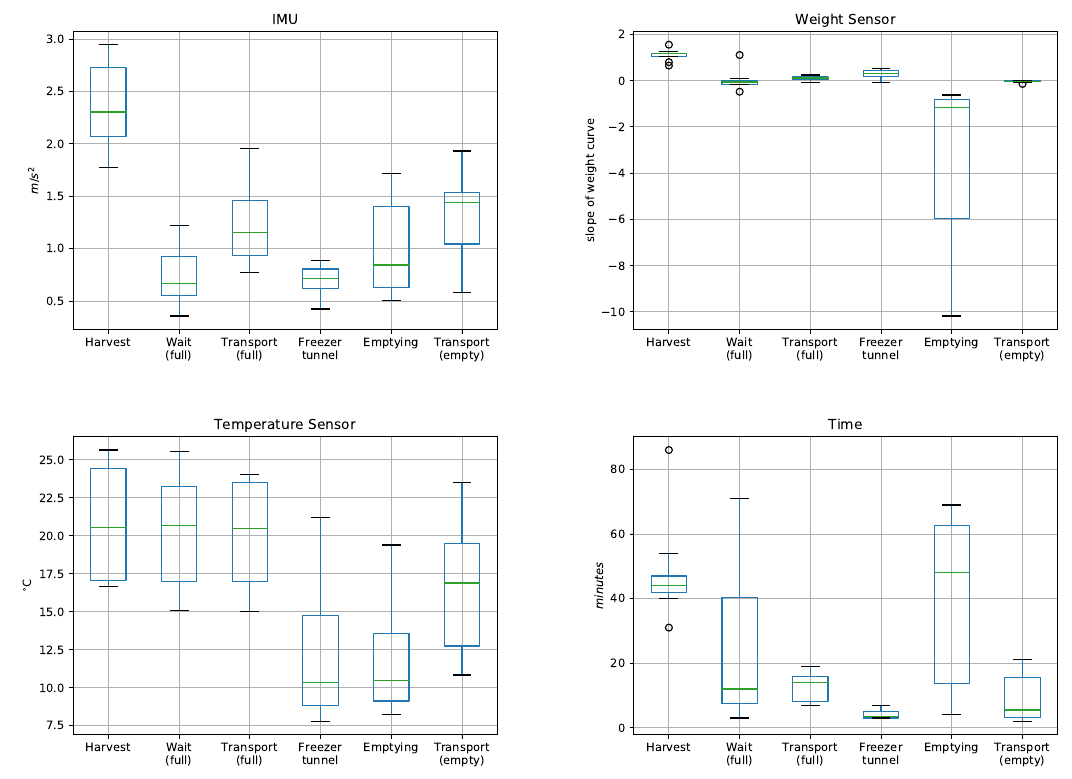
Figure 6. Boxplot of the results of the five nodes for each stage of the harvest